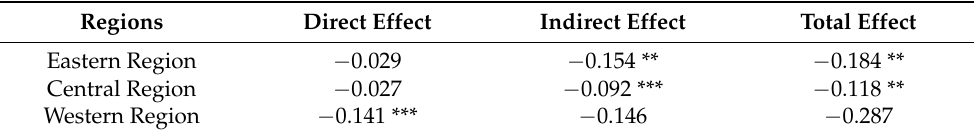
Table 10. Heterogeneity results of the eastern, central, and western regions. Regions Direct